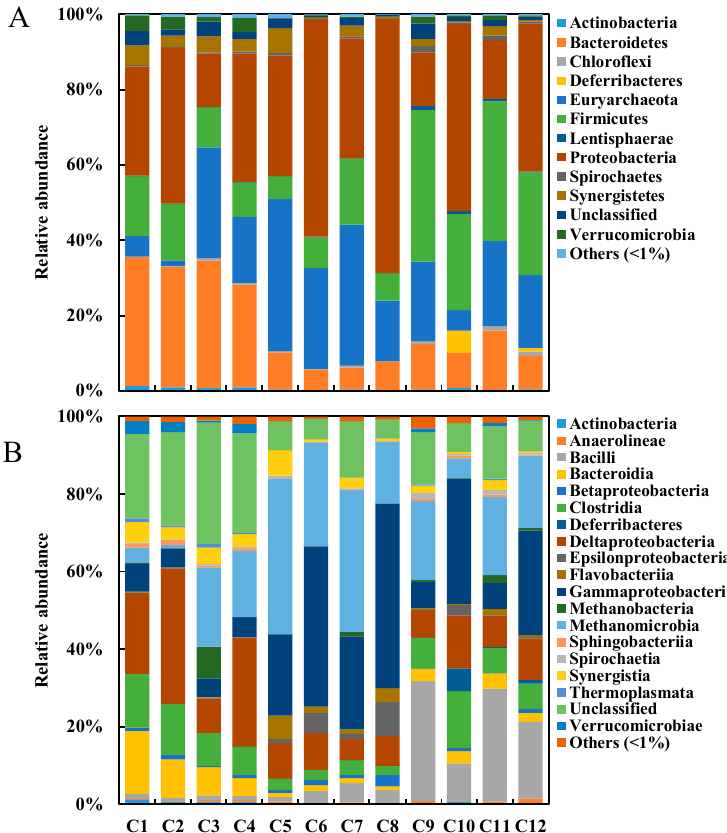
Figure 5. Microbial community comparison at phylum ( A ) and class ( B ) level.